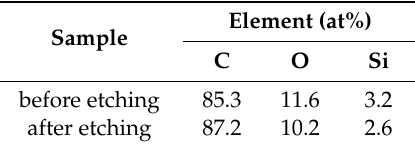
Table 3. Relative C, O, and Si contents (in %) from XPS elemental survey measurements (see also Figure 3) on Si/MC samples before and after HF etching.